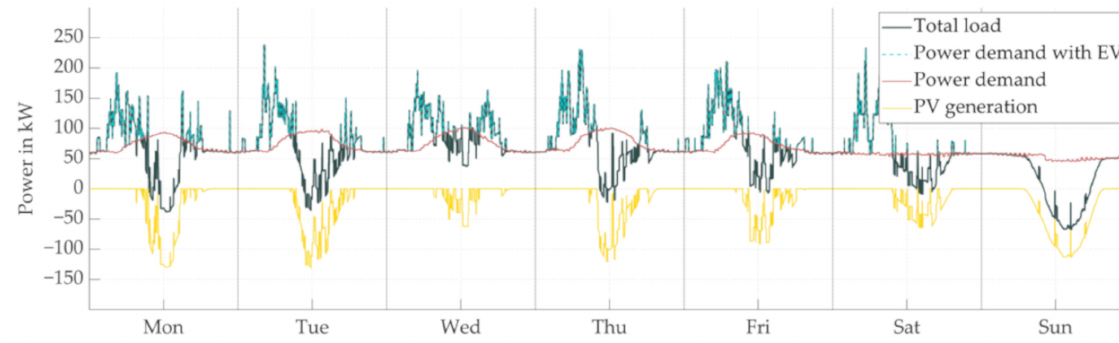
Figure 16. The control algorithm for model II.